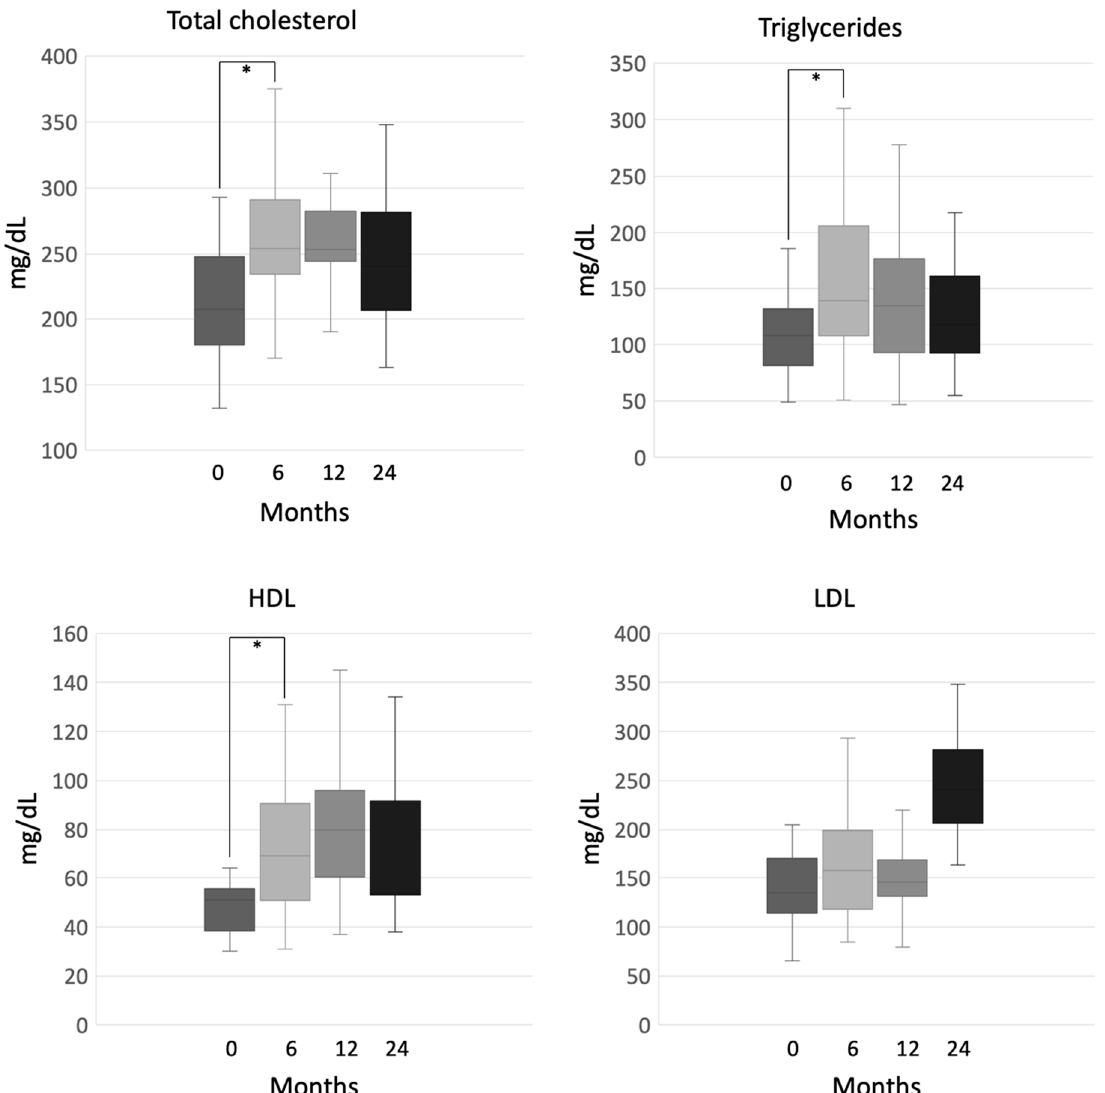
Figure 5. Total cholesterol, triglycerides, high-density lipoprotein (HDL) and low-density lipoprotein (LDL) cholesterol during mitotane therapy, * indicates statistical significance, Note: patients who put on lipid-lowering therapy were excluded from the analysis.